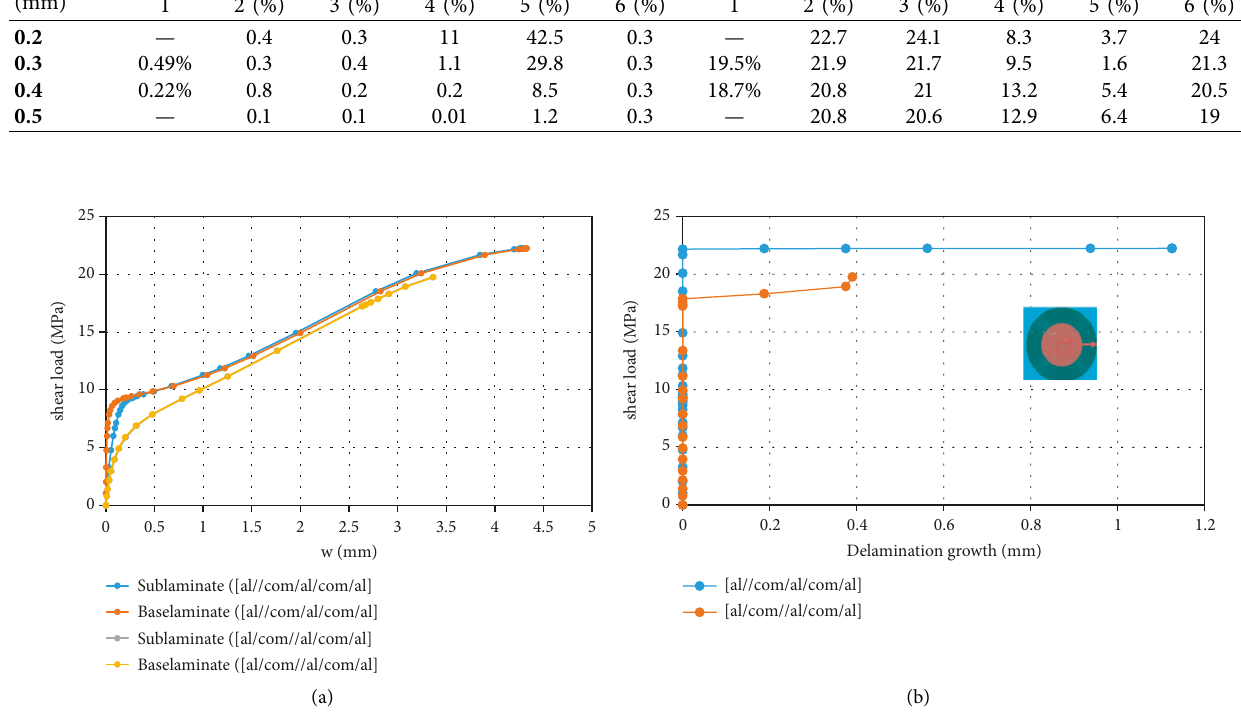
Figure 7: (a) Postbuckling behaviour of GALRE 3-3/2-0.2 and (b) delamination growth of GALRE 3-3/2-0.2.